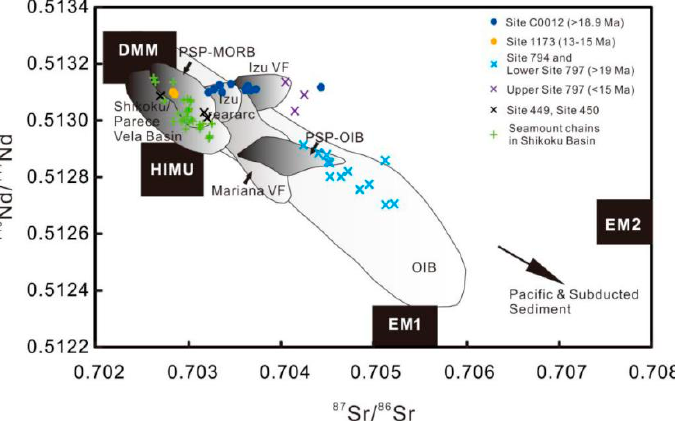
Figure 10. Nd and Sr isotopic compositions of Cenozoic volcanic rocks of the Site C0012 and Site 1173 in the Shikoku Basin. Data sources as for Figure 6. The Site 449, 450 data in the Parece Vela Basin are from Reference [61]; the fields of Izu-Bonin arc lava and Mariana arc lava are cited from Reference [57]; the fields of PSP-MORB (Philippine Sea Plate-MORB), PSP-OIB (Philippine Sea Plate-OIB), Shikoku and Parece Vela back-arc basins, Izu rear-arc, Izu volcanic front (Izu VF) are cited from Reference [62]; the fields of EM1, EM2, depleted mantle (DMM) are cited from Reference